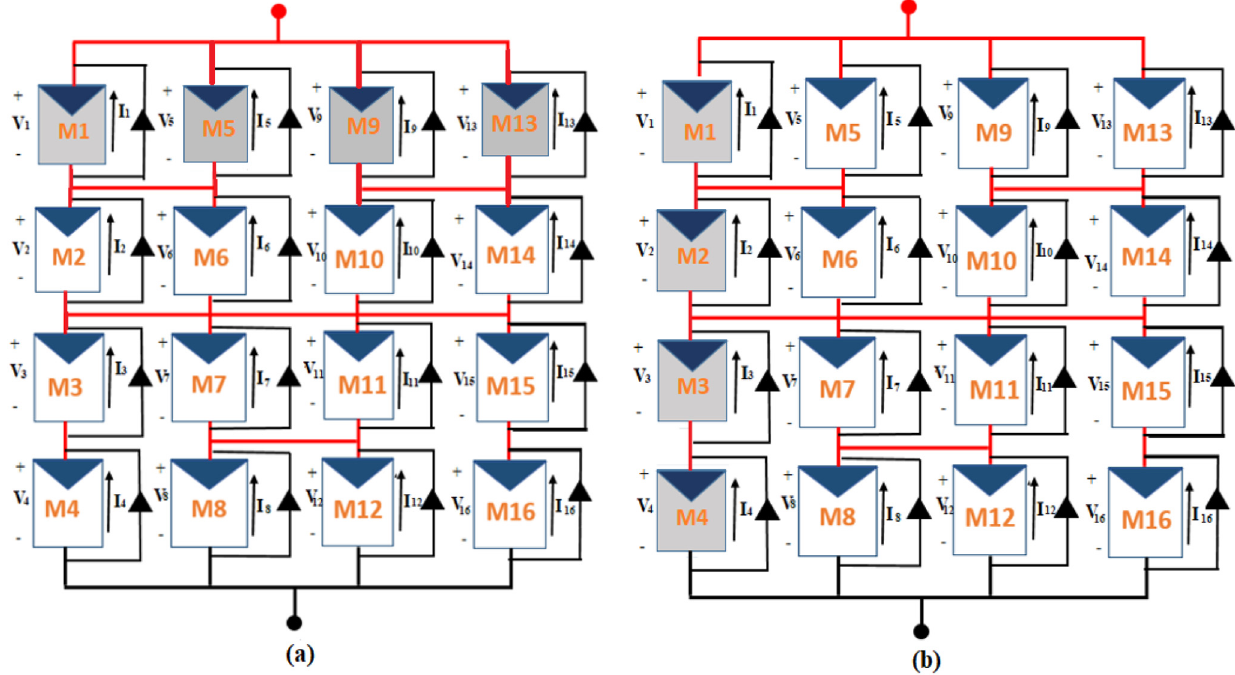
Fig. 9. HCTCT con fi guration (a) ERD shading pattern (b) ECD shading